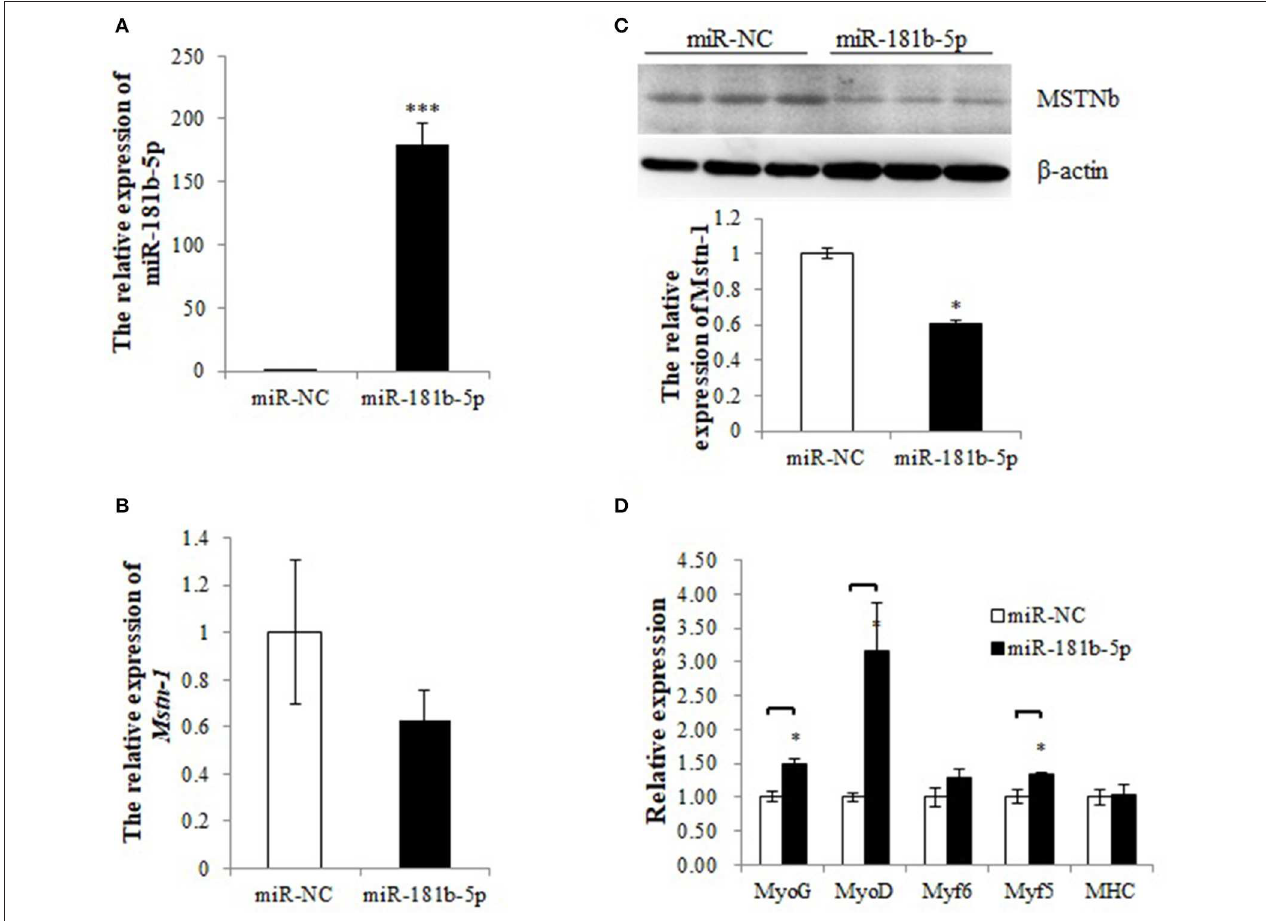
FIGURE 7 | miR-181b-5p overexpression influences the expression of Mstnb and its downstream genes. (A) The relative expression of miR-181b-5p. (B) The mRNA expression of Mstnb. (C) The protein level of Mstnb. (D) The mRNA expression of Mstnb downstream genes. Bar: mean ± SEM. * P < 0.05 and *** P < 0.01, One-way ANOVA analysis, n =